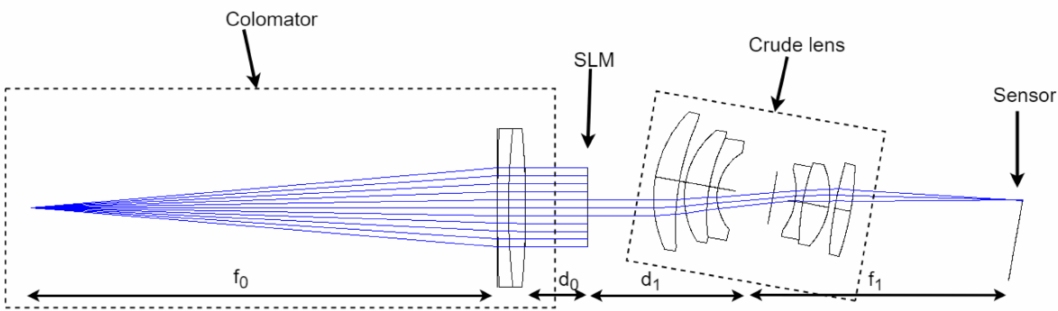
Figure 5. Simulated experimental setup built in